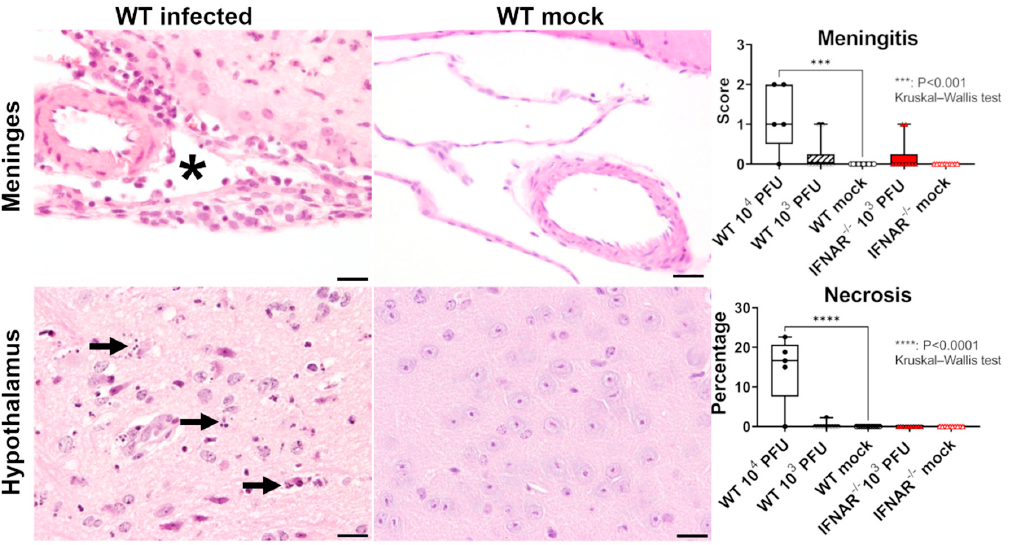
Figure 2. Histological findings in the brain of mice infected with Rift Valley fever virus (RVFV). Moderate lymphohistiocytic leptomeningitis (asterisk) in a wild type (WT) mouse at 11 days post infection (dpi) with 10 4 plaque-forming units (PFU) RVFV. Hypothalamic neuronal necrosis (arrows) in a WT mouse at 11 dpi with 10 4 PFU RVFV. No lesions in the meninges and hypothalamus of a mock-infected control animal